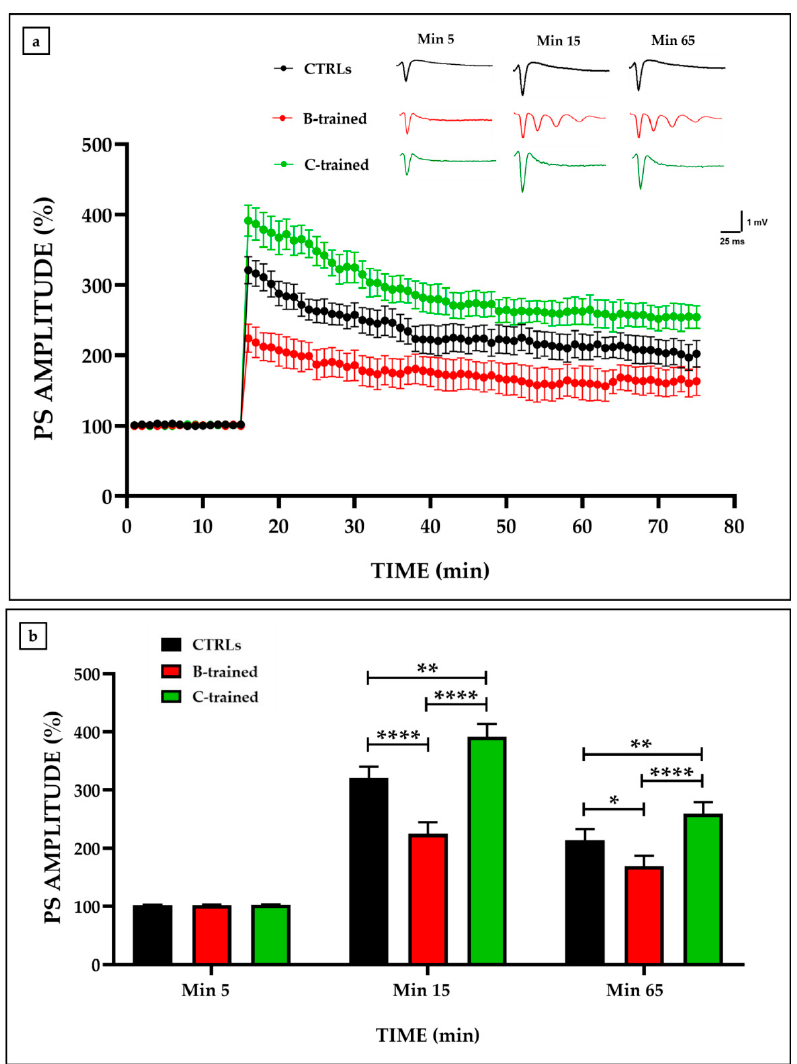
Figure 1. Synaptic plasticity in the CA1 hippocampal subfield of trained and sedentary mice. ( a ) Percentage population spike (PS) amplitude as a function of time after high-frequency stimulation (HFS), applied at time t = 15 (arrow), is shown in CTRLs (black line, n = 8 from N = 5), in B-trained (red line, n = 6 from N = 5), and in C-trained (green line, n = 7 from N = 5) mice slices. The insert shows representative recordings obtained from slices of each experimental group. The first curve in each group refers to the basal synaptic transmission and it was recorded prior to the HFS application, whereas the other curves represent the PS measured at 15, immediately after HF, and 65 min after HFS. ( b ) The PS amplitude values at min 5 (black bar), at min 15 (red bar), and at min 65 (green bar) from the HFS are shown for each experimental group. Bars in the plot are means ± SEM of values obtained from different slices. Note that a significant statistical difference was reported between trained and control groups at min 15 (CTRLs vs. B-trained, **** p < 0.0001; CTRLs vs. C-trained, ** p < 0.01; B-trained vs. C-trained, **** p < 0.0001; F = 19.92) and at min 65 (CTRLs vs. B-trained, * p < 0.05; CTRLs vs. C-trained, ** p < 0.01; B-trained vs. C-trained, **** p < 0.0001; F =